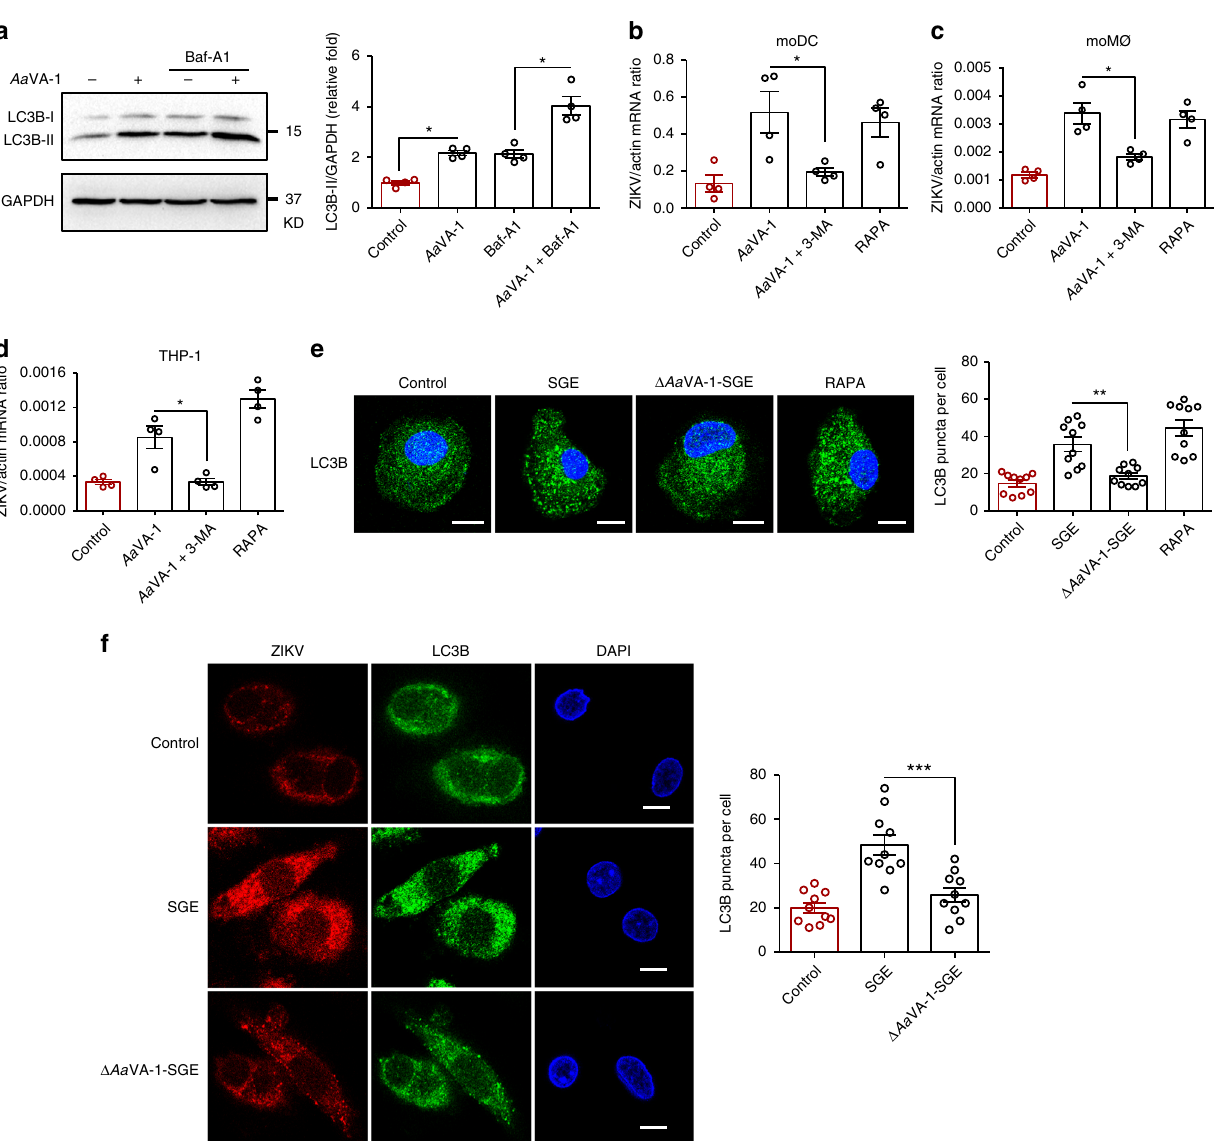
Fig. 4 Aa VA-1 facilitates fl aviviral infection by activating autophagy. a The role of Aa VA-1 in activation of autophagy in human THP-1 cells. Aa VA-1 (1 μ g/ml) was incubated with THP-1 cells with or without Baf-A1. An equal amount of BSA served as a mock control. At 6 h post incubation, autophagy activity was assessed by western blotting with anti-LC3B antibody (left panel), and quanti fi cation of the signaling intensity of LC3B-II relative to GAPDH (right panel). n = 4 independent experiments. b – d Interruption of autophagy with the antagonist 3-MA impaired Aa VA-1-mediated ZIKV enhancement in moDC ( b ), moMØ ( c ), and THP-1 cells ( d ). Aa VA-1 (1 μ g/ml) was incubated with the cells with or without 5 mM 3-MA. An equal amount of BSA served as a mock control. The autophagy agonist RAPA was used as a positive control. At 24 h post incubation, the viral load was detected by qRT-PCR. Gene quantities were normalized against human actin (NM_001101.4). n = 4 independent samples. The experiments were repeated three times with the similar results. e , f Aa VA-1 in the A. aegypti SGE enhanced both antophagic activation and ZIKV replication in human moMØ. Human moMØ cells were infected